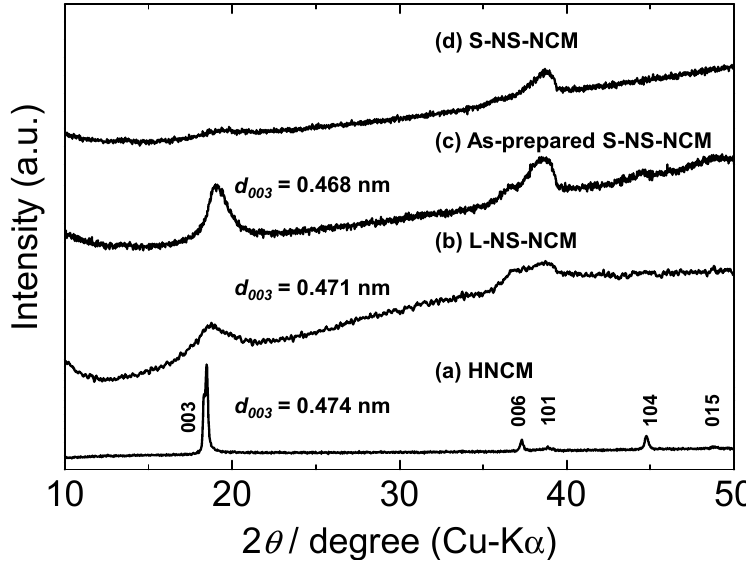
Figure 2. XRD patterns for ( a ) HNCM; ( b ) L-NS-NCM; ( c ) as-prepared S-NS-NCM; and ( d )